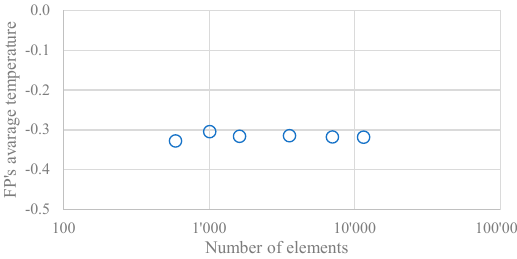
Figure 5. Results of mesh independence study.